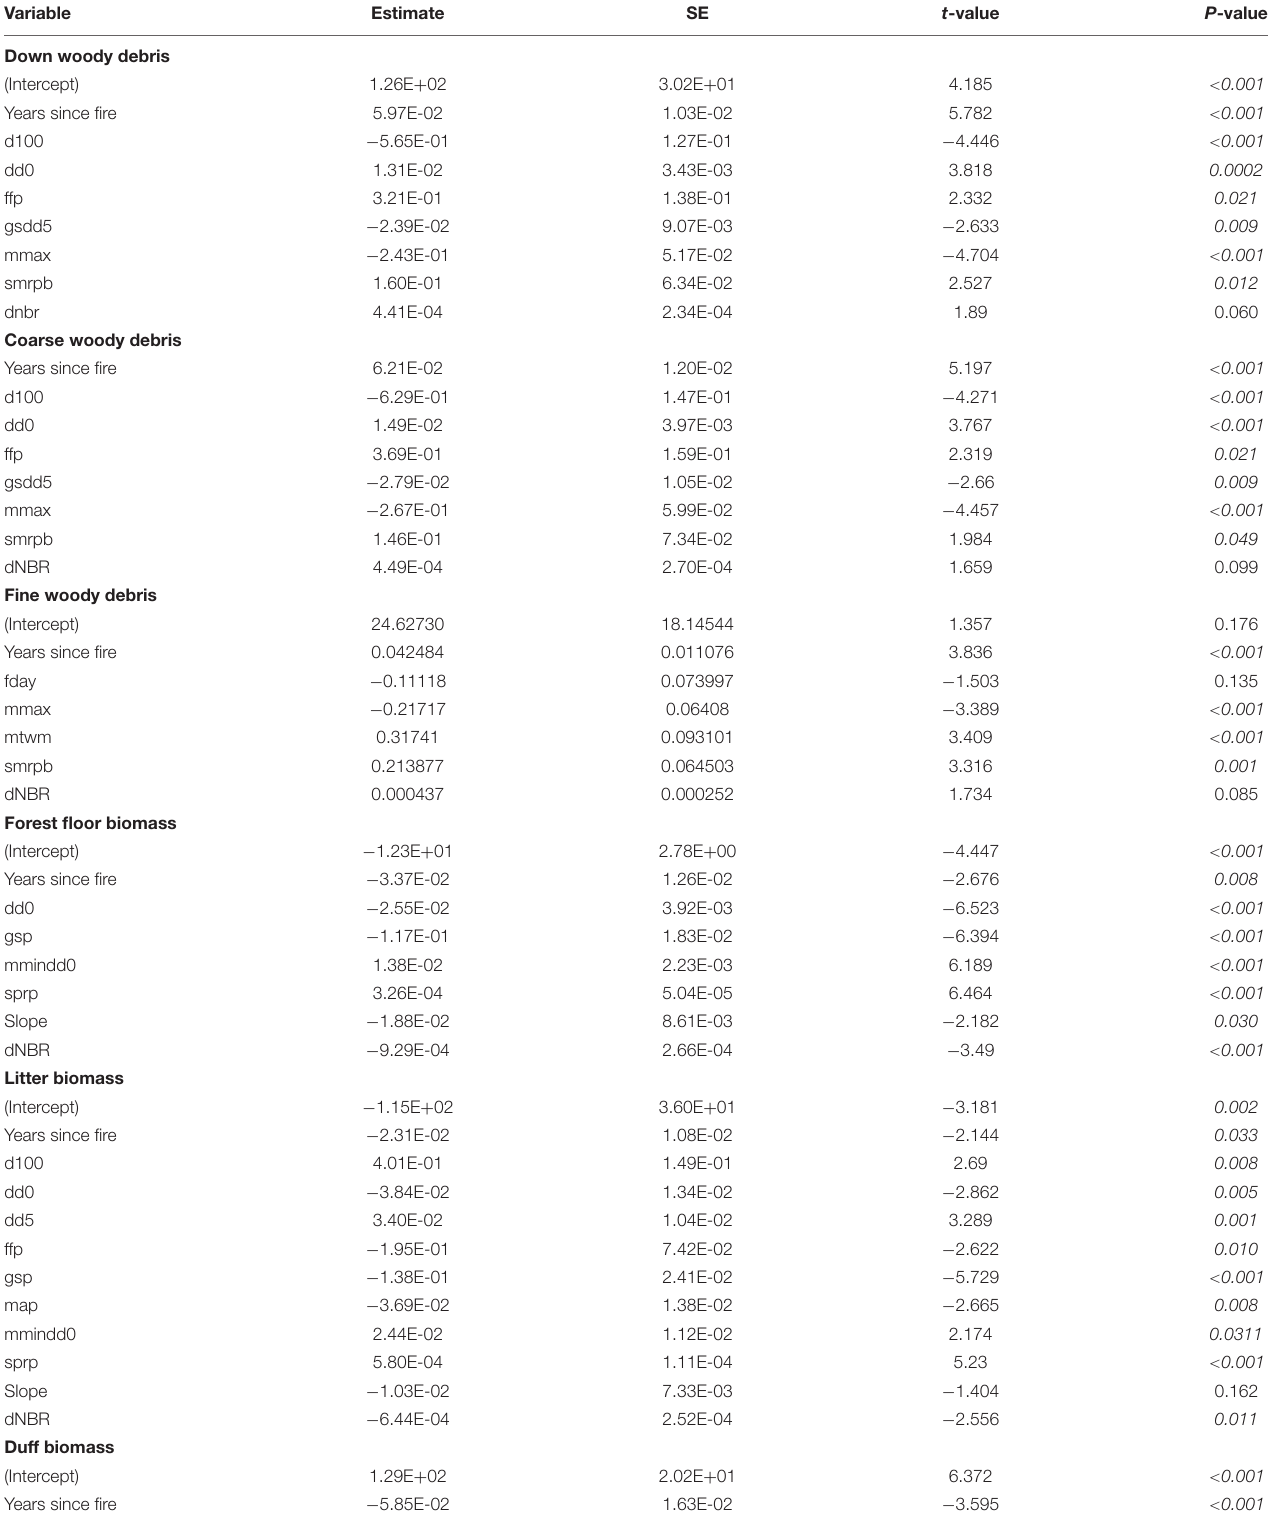
TABLE 3 | Results of generalized linear models (GLM) of site climate variables, topography, years since fire, and severity (dNBR) to predict total downed woody debris, coarse woody debris, fine woody debris, forest floor biomass, litter biomass, and duff biomass.